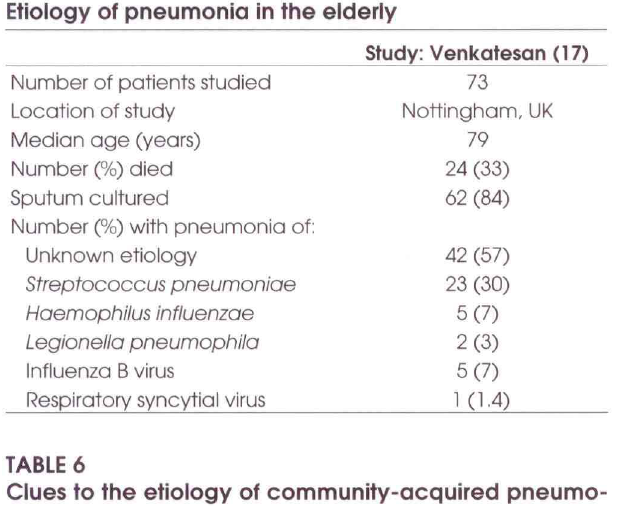
Clues to the etiology of community-acquired pneumo nia from